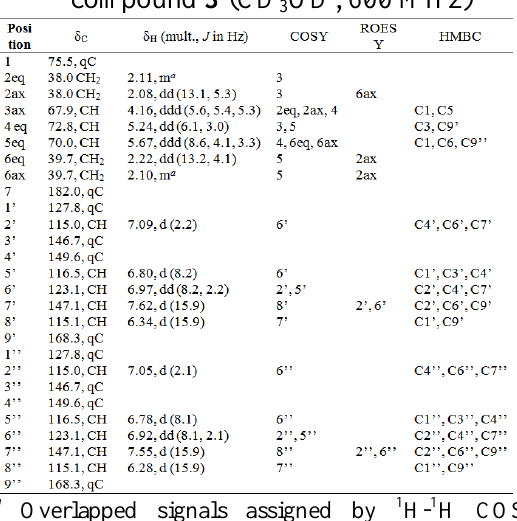
Table 2. NMR spectroscopic data